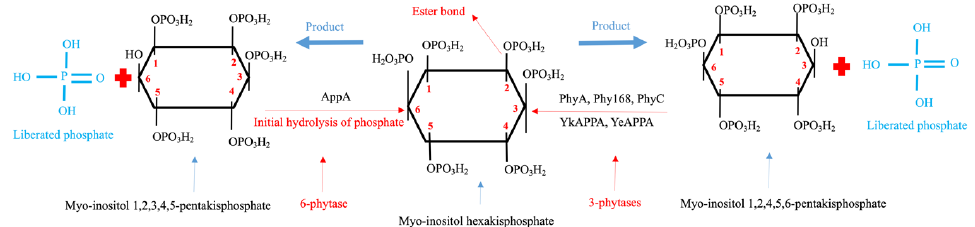
Figure 3. Catalytic reactions of 3 and 6-phytases3-phytases start the hydrolysis of ester bond between phosphate group and inositol ring at position C3, while 6-phytases start to attack at position C6 of inositol ring and liberate phosphate.